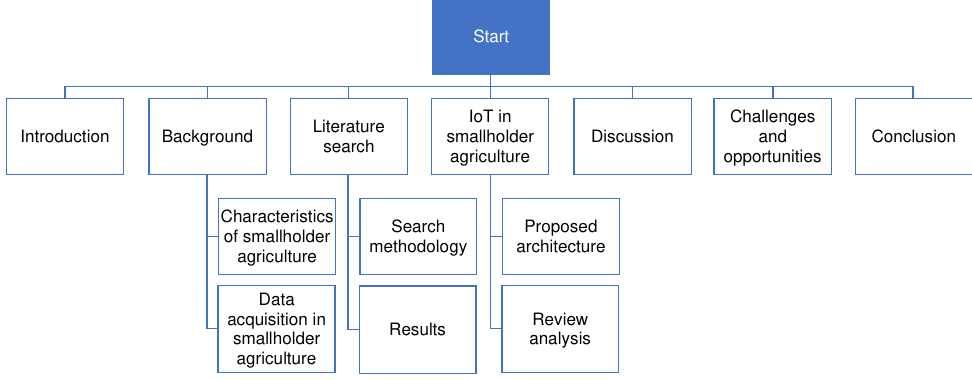
Figure 1. Schematic workflow representation of the proposed